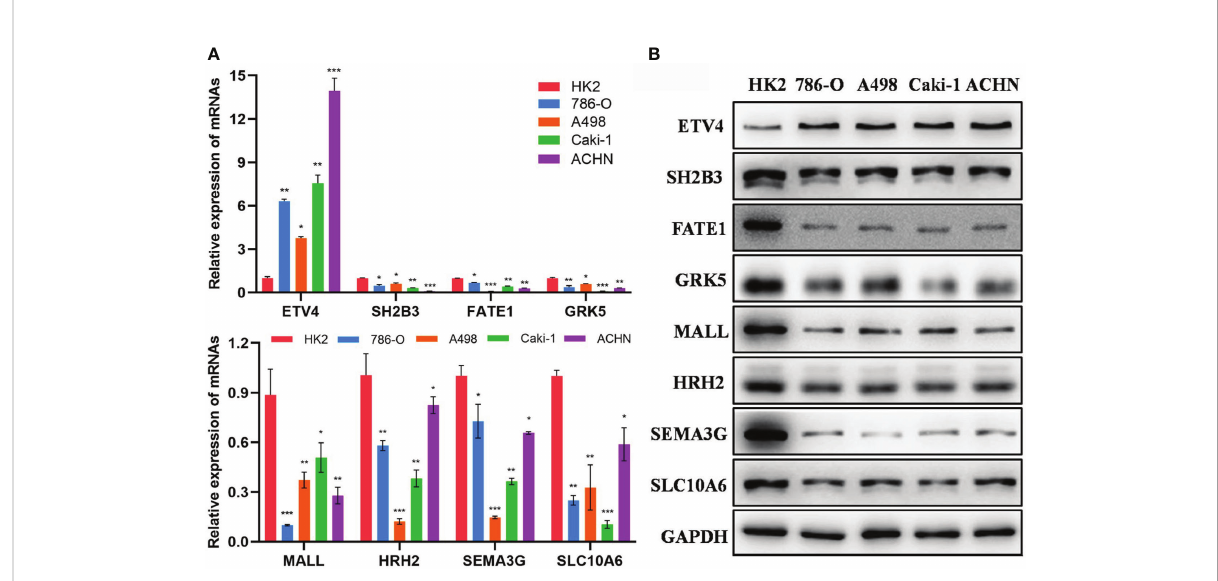
FIGURE 11 Veri fi cationoftheexpressionlevel of 8epi-PCGs invitro . (A) ThemRNA expression level of 8 epi-PCGs (ETV4, SH2B3, FATE1, GRK5, MALL,HRH2, SEMA3G and SLC10A6)in4kidneycancercelllinesandHK2 cell line. (B) The proteinexpressionlevel of 8epi-PCGs. *P <0.05, **P< 0.01, ***P<